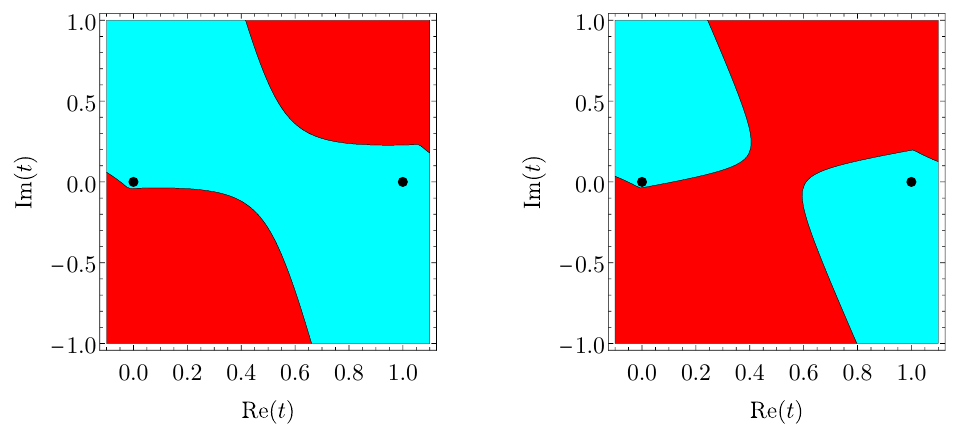
Figure 2 . An example of the ridge obstruction picture in the complexified t plane. The ‘seas’ (cyan regions) are where Σ spatial ( t ) < π , and the ‘ridges’ (red regions) are where Σ spatial ( t ) ≥ π . On the left, one has an example where the ridges do not present an obstruction and where we can find a simply connected smooth path between t = 0 and t = 1 (represented in both pictures by the black dots) along which Σ spatial ( t ) < π . Whether the LSKSW bound can actually be satisfied along such a path is however not guaranteed and must be decided based on other methods. On the right, one has an example where there is a ridge obstructing the way between t = 0 and t = 1 . This implies that the LSKSW bound is necessarily